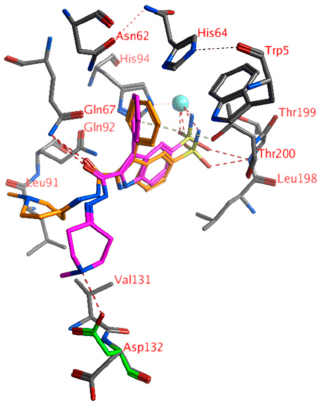
Figure 2. The docked pose of compound 23 (orange and purple) in the active site of hCA IX (3iai). Hydrogen bonds and interactions with the zinc ion are indicated in red dashed lines. H-arene interactions are indicated in yellow dashed lines. The zinc ion is indicated as a turquoise sphere. The Asp132 rotamer that was able to form a hydrogen bond with the ligand is indicated in green sticks.